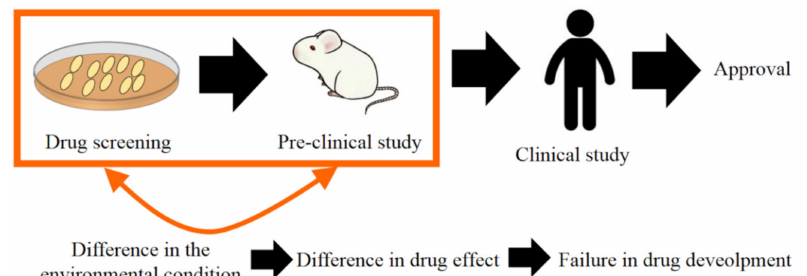
Figure 1. Research and development process of drug development. The di ff erence in the environment condition between in vitro and in vivo leads to that in drug e ff ects, which often causes a failure in drug development.